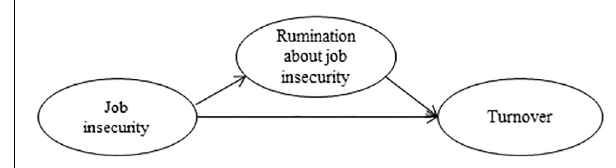
FIGURE 1 | Theoretical model of job insecurity and turnover through rumination about job